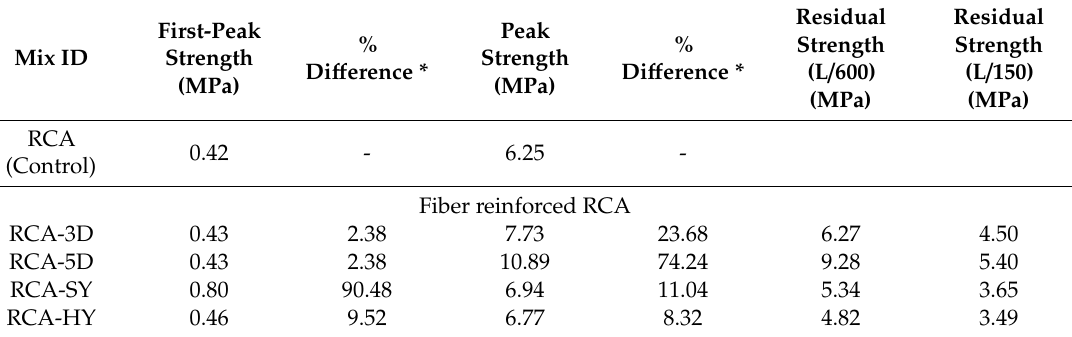
Table 9. Summary of the flexural strength results.